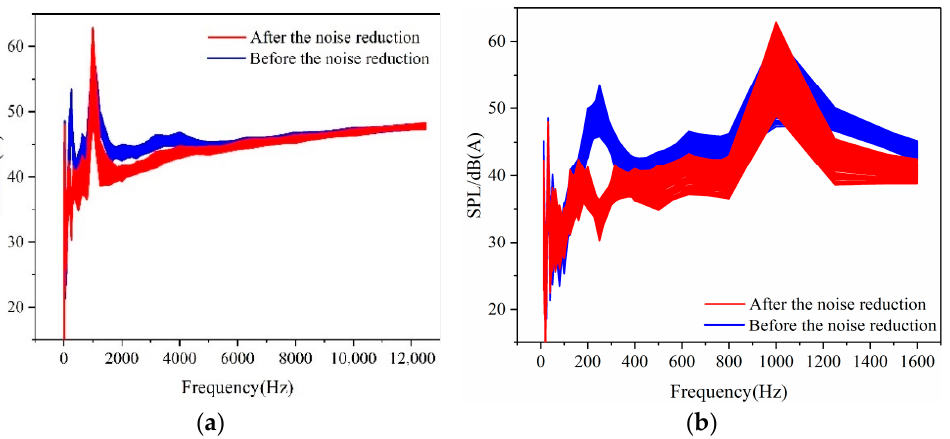
Figure 15. Variation in SPL in the frequency. ( a ) Change in SPL within the frequency range of 0 to 12,000 Hz, ( b ) change in SPL within the frequency range of 0 to 1600 Hz. Table 3. SPL at each frequency point before and after noise reduction.